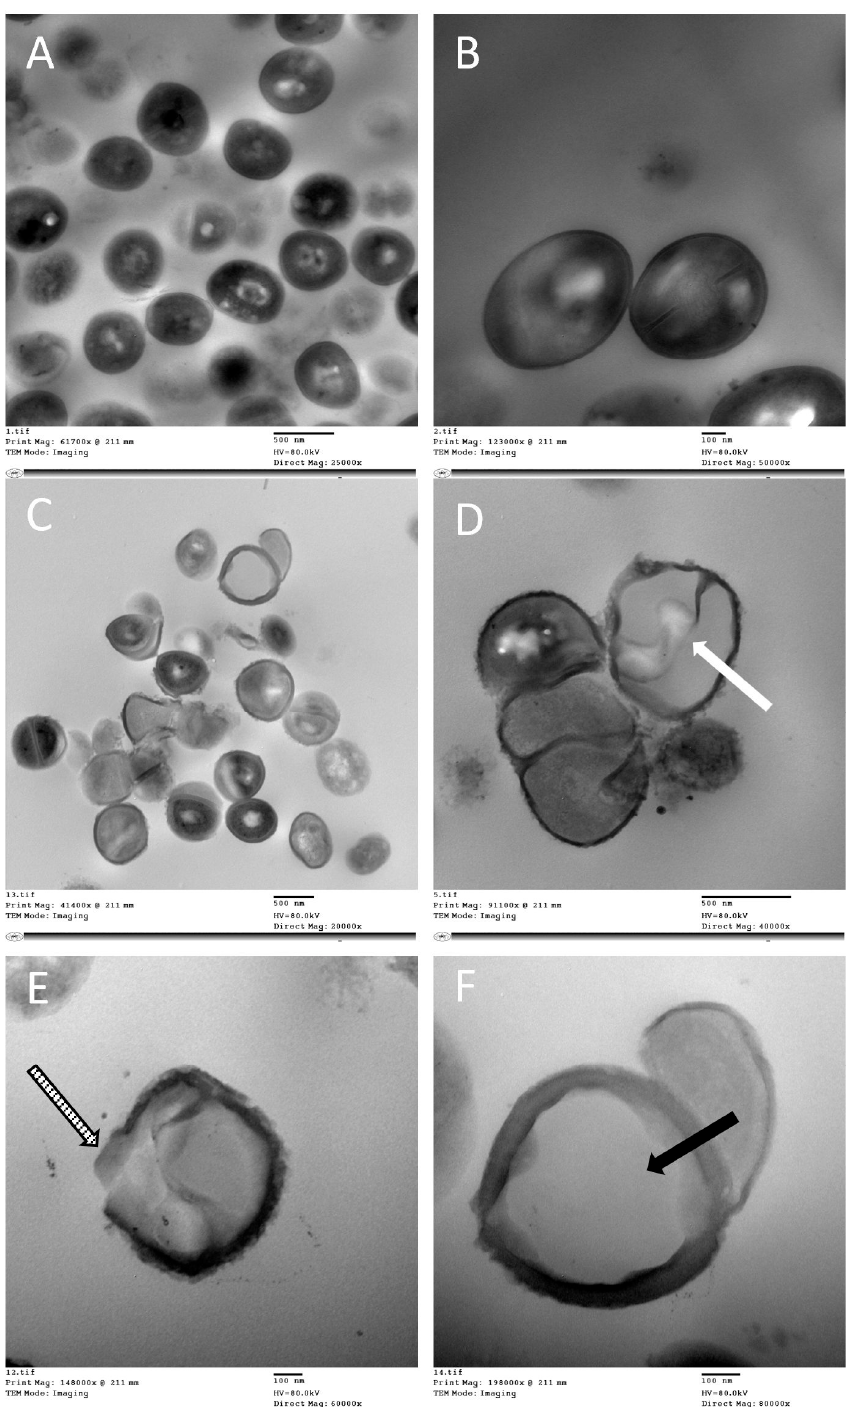
Figure 4. TEM images presenting the structural changes in Staphylococcus aureus after treatment with rhamnolipid nano-micelles at concentrations less than the MIC. Images ( A , B ) show a normal cell wall outline without any itching or degradation, and with a normal central plane of division and complete cellular components. Image ( C ) shows abnormal cell morphologies. Images ( D – F ) show the possible antibacterial mechanisms recorded for the rhamnolipid nano-micelle solution: ( D ) abnormal cell division as revealed by an incomplete central plane of division (white arrow); ( E ) abnormal, degraded, itched, and permeabilized cell wall (striped arrow); and ( F ) bleaching of intracellular components (black arrow).